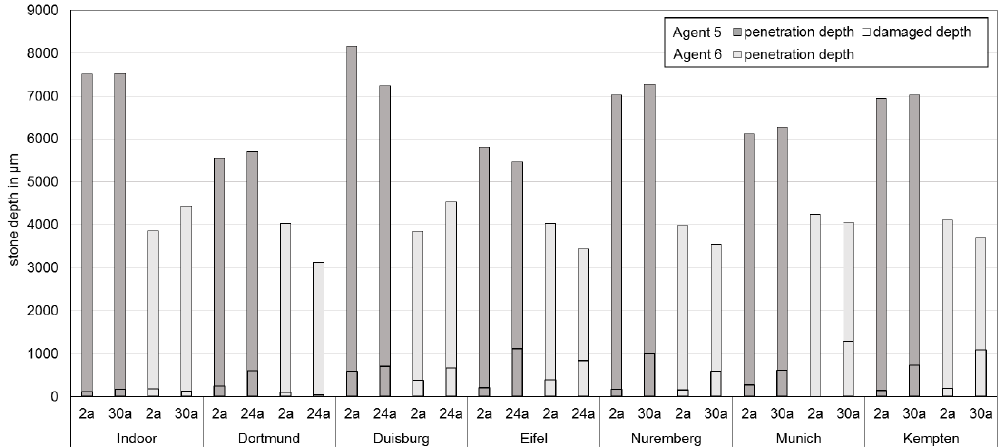
Figure 14. Comparison of the penetration depth of agents 5 or 6 applied on OKS with the damaged depth calculated with Equation (5) (depth 0 = surface of the stone).